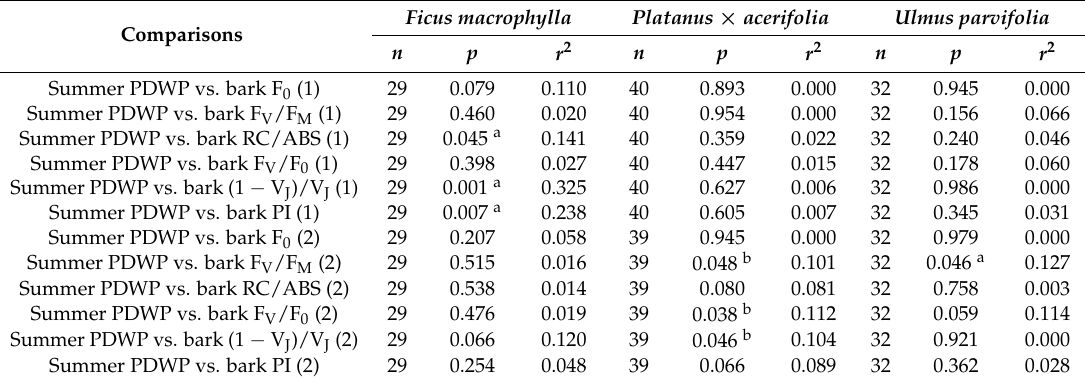
Table 4. Summarized results from simple linear regression analyses comparing summer bark fluorescence with pre-dawn water potentials. Linear regressions using the 95% confidence interval.